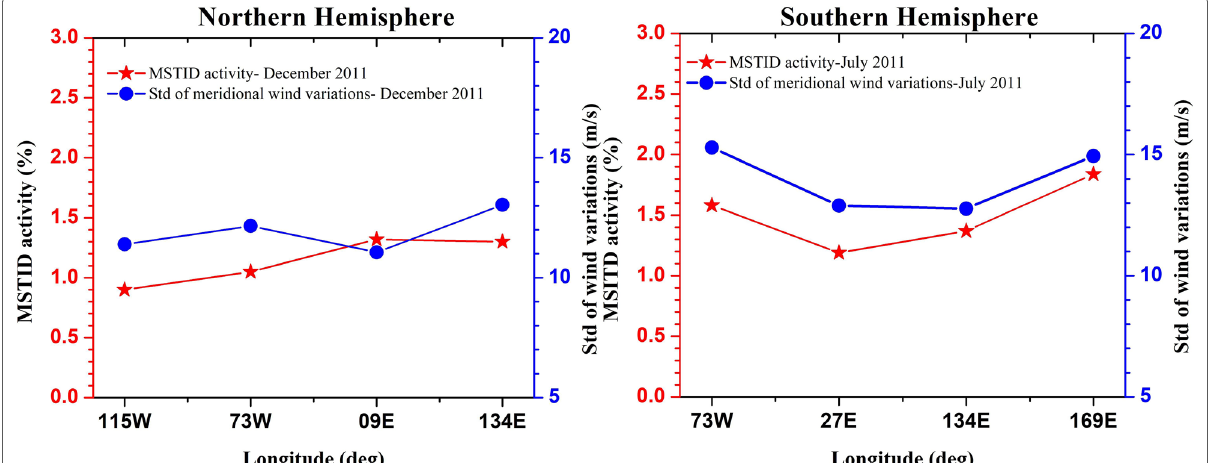
Fig. 7 Comparison of longitudinal variation of GAIA-simulated daytime MSTID activity and standard deviation of meridional wind variations during the maximum occurrence period (i.e. December in NH and July in SH) in GPS observation (blue). Horizontal axis denotes the longitudes, and vertical axis at the left and right sides represent the MSTID activity and standard deviation of meridional wind variation,